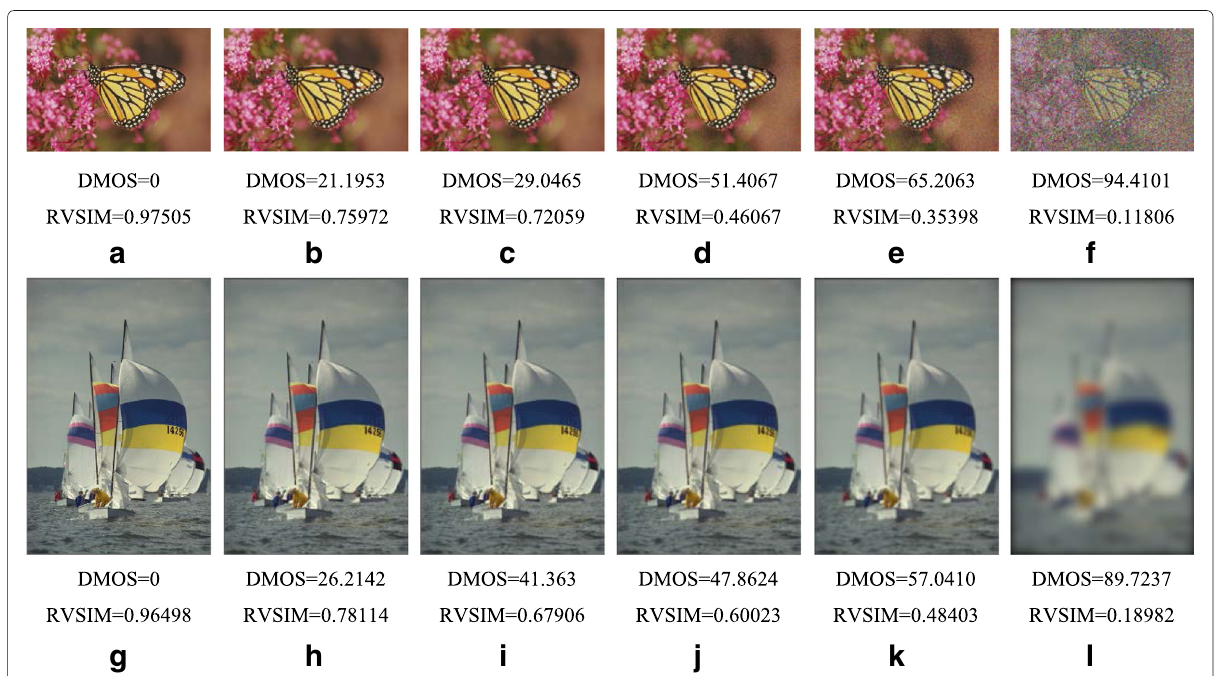
Fig. 7 Two group of images and their corresponding subjective/objective scores. a – f The original image monarch and five noise-distorted images. g – l The original image sailing 2 and five blur-distorted images